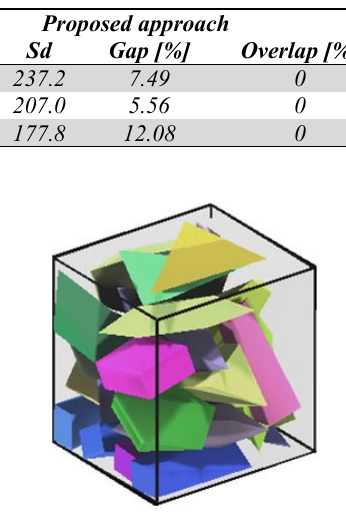
Fig. 17. Best solution obtained of the instance SGSPM05 c12